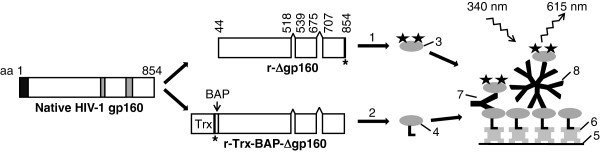
Design of r-Δgp160 and r-Trx-BAP-Δgp160 antigens and TRF assay. The left part of the figure shows a schematic representation of the native HIV-1 gp160 molecule. The black and grey boxes denote the signal sequence and the two internal hydrophobic regions in the C-terminal half of native gp160, respectively. Depicted in the middle part of the figure are the two recombinant antigens created for this study, r-Δgp160 and r-Trx-BAP-Δgp160. Both lack the signal sequence (black box) and the two internal hydrophobic regions (grey boxes) of native gp160. An additional sequence consisting of thioredoxin (Trx) and biotin acceptor peptide (BAP) was fused to the N-terminus in r-Trx-BAP-Δgp160. Both proteins were provided with 6x-His tags whose positions are indicated by the asterisks. The numbers indicate the starting and ending aa residues of the native gp160 sequences retained, and fused in-frame, in the recombinant antigens. Shown to the right is design of the double antigen sandwich assay: the r-Δgp160 and r-Trx-BAP-Δgp160 antigens were labeled with Eu3+-chelate and biotin isothiocyanate, respectively. These labeling reactions (denoted by 1 and 2) produced r-Δgp160-Eu3+ (3) and r-Δgp160-Bio (4). The biotinylated capture antigen r-Δgp160-Bio was bound to SA (6) coating the microtiter well surface (5). Serum anti-HIV-1 IgG (7) and IgM (8) that are captured in the wells are revealed using the tracer, r-Δgp160-Eu3+ (3), and visualized by excitation at 340 nm followed by time-resolved measurement of fluorescence at 615 nm.